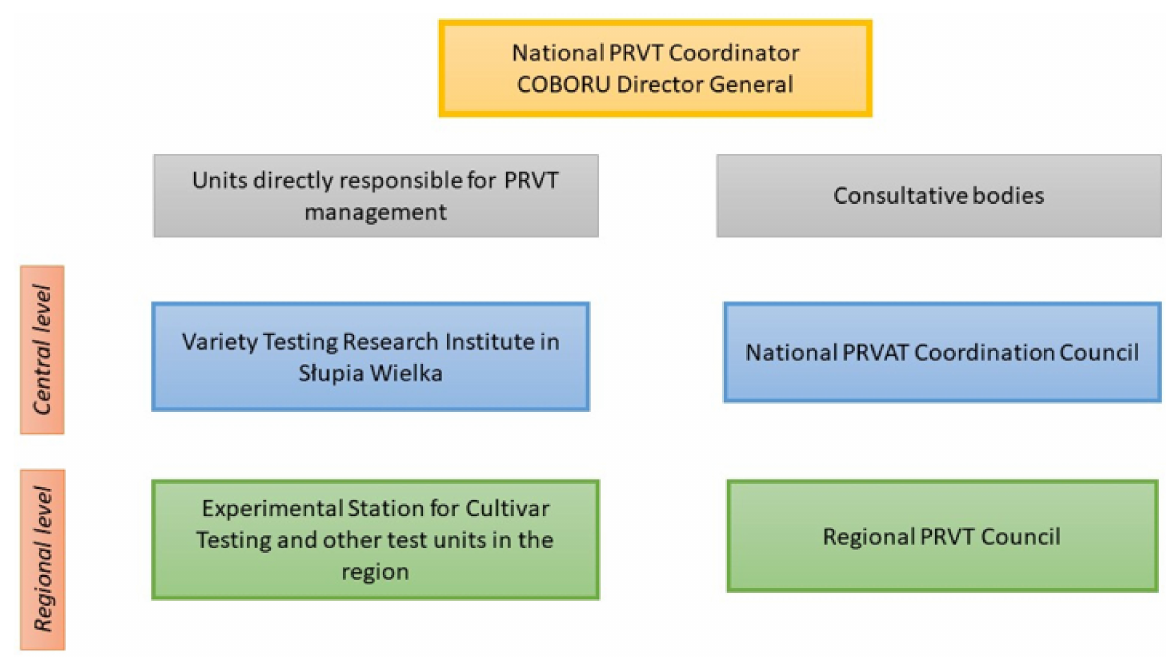
Figure 1. Organization of PRVT testing and variety recommendation system in